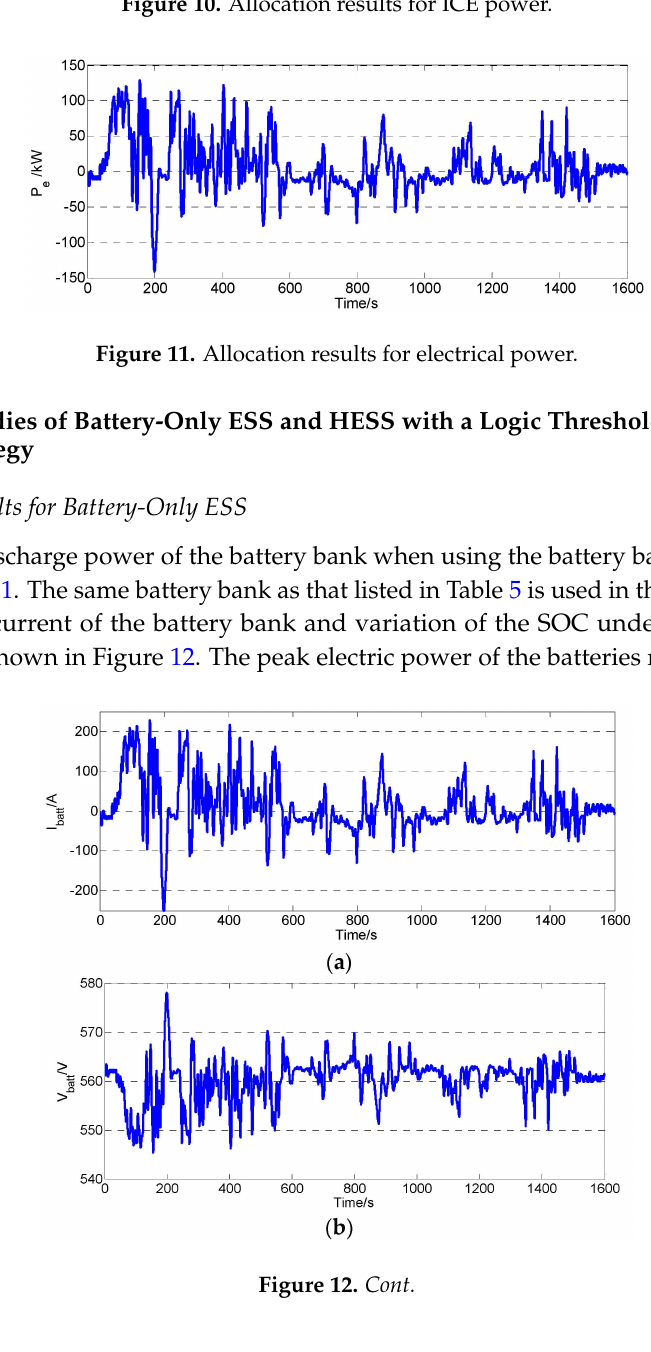
Figure 10. Allocation results for ICE power.